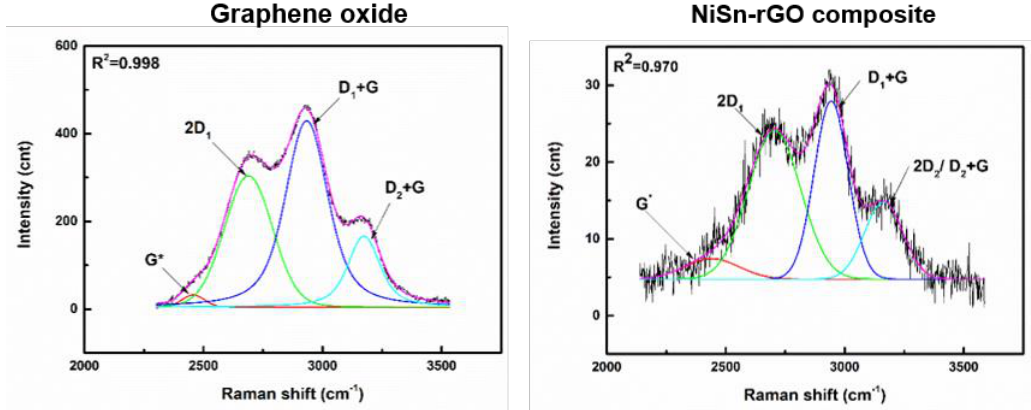
Figure 11. Deconvolution of the peaks from the 2nd order Raman region of graphene oxide and the NiSn-rGO-P3.3 composite. The sum of the deconvolution is shown with an orange line. The D band corresponds to the A 1g breathing mode of the disordered sp 2 -hybridized